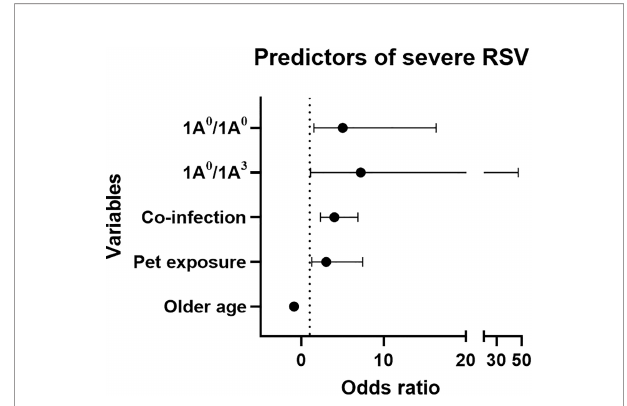
FIGURE 1 | Forest plot represents predictors of severe RSV using mutivariable logistic regression analysis. X-axis and Y-axis represents odds ratio (OR) and variables, respectively. Dotted line represents OR of 1. Based on OR, 1A 0 /1A 0 , 1A 0 /1A 3 , pet exposure and co-infection are associated